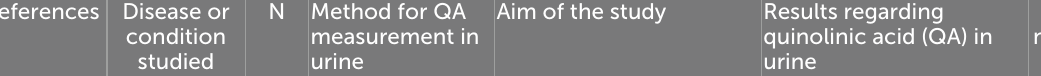
TABLE 1 Studies measuring urinary quinolinic acid in